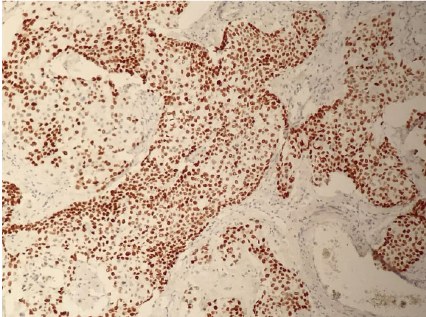
Figure 5: Immunohistochemistry HEX20 intense nuclear marking of tumor cells at P63.